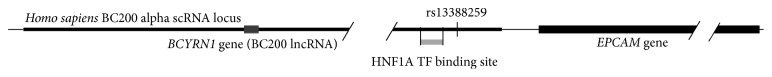
The genomic region on Chromosome 2 in which rs13388259 occurs. The rs13388259 SNP is an intergenic polymorphism located on the short arm of Chromosome 2 (Ch2:47,343,700) between the BCYRN1 and EPCAM genes. The 200 nt BCYRN1 lncRNA gene is located at positions 47,335,315-47,335,514 (ENSG00000236824) and overlaps with the Homo sapiens BC200 alpha scRNA locus (accession number AF020057.2; 13,472 bp length; position 47,331,060-47,344,531). The EPCAM gene (Chr2:47,345,158-47,387,601; ENSG00000119888) is located 1458 bp downstream of the SNP. The HNF4A transcription factor binding site is located approximately 236 bases upstream of the rs13388259 SNP (Ch2:47,343,088-47,343,464). Genomic positions are relative to GRCh38.